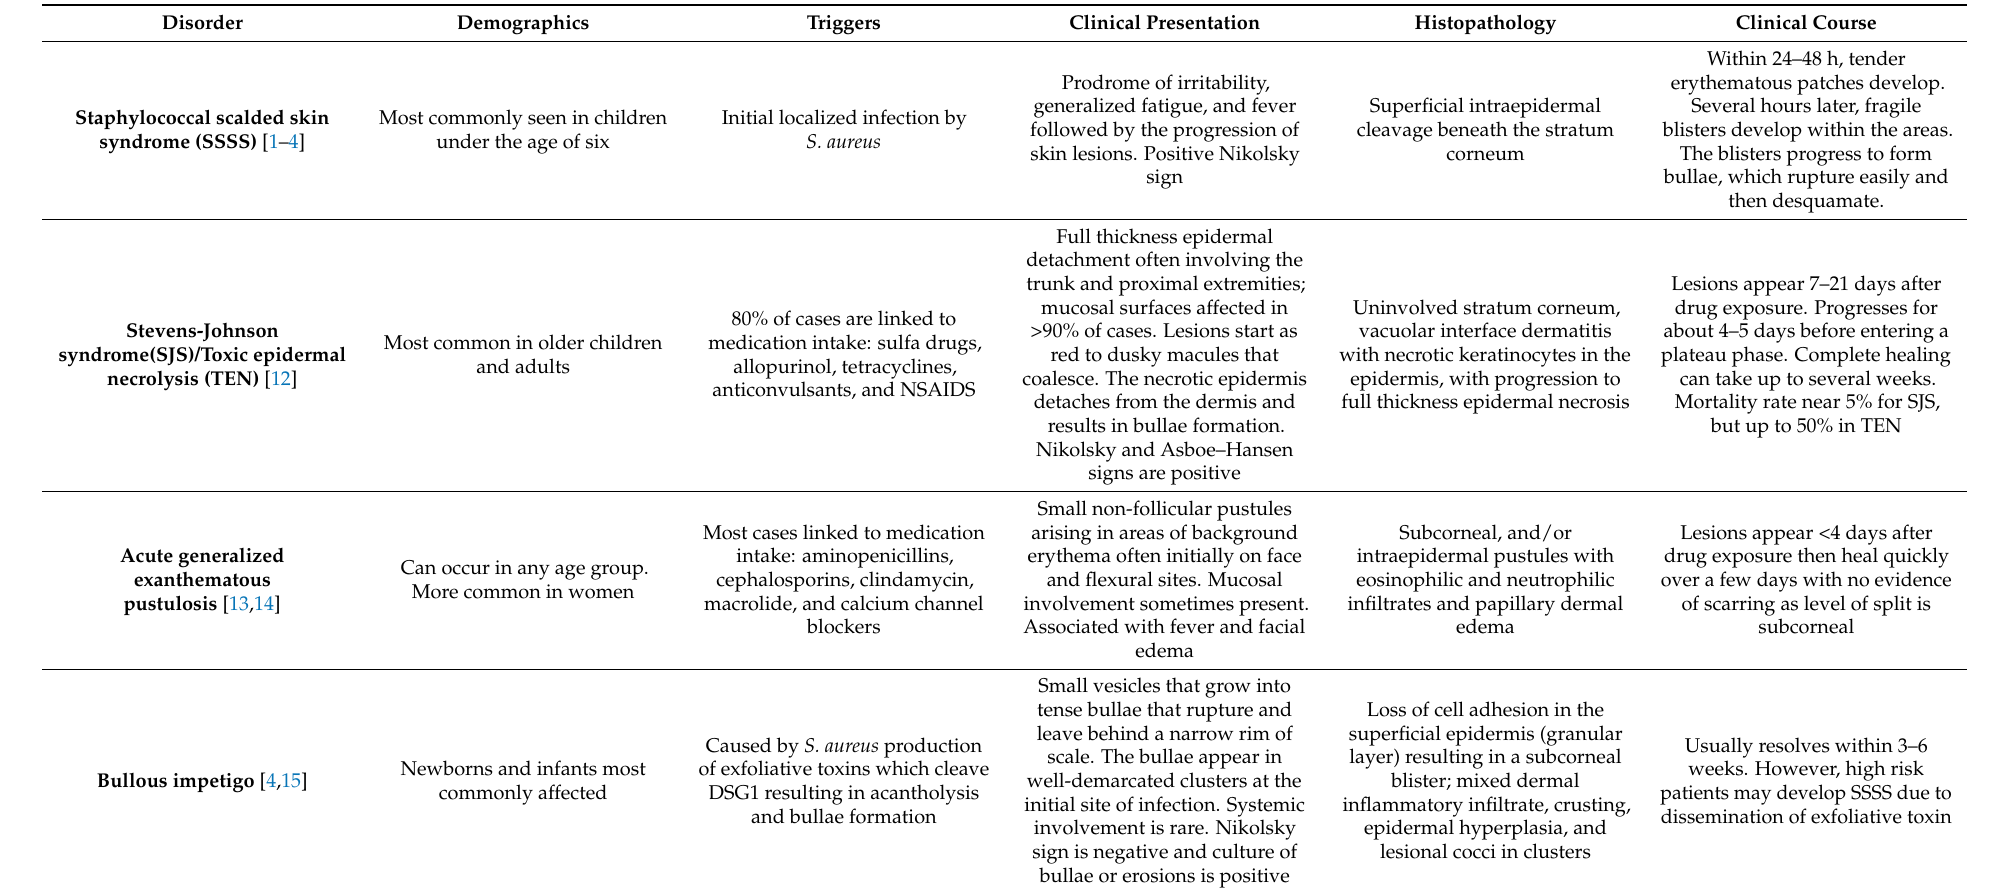
Table 2. Differential diagnosis of